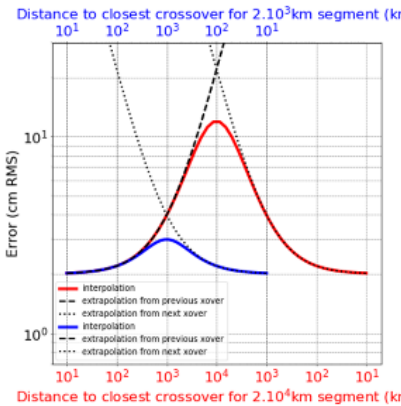
Figure 23. Qualitative example of how the omission error increases for a K − 2 power law as described in [3] (p. 77). For two arbitrary segments (2000 km in blue and 20,000 km in red) the bell-shaped curves correspond to the integration of a K −2 power law similar to the uncalibrated systematic error allocations in the SWOT error budget (black dotted/dashed lines). The error is maximal at the center of the segment, when the distance to the closest ocean crossovers at the beginning/end of the segment is the same.